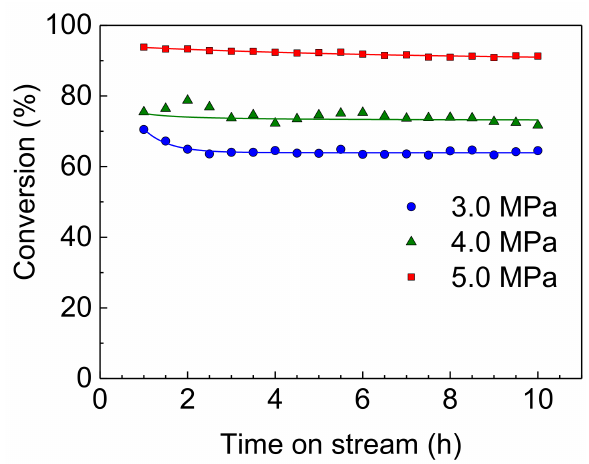
Figure 5. HDS of 4,6-DMDBT over a Rh-P catalyst at 310 ◦ C and 3.0–5.0 MPa.